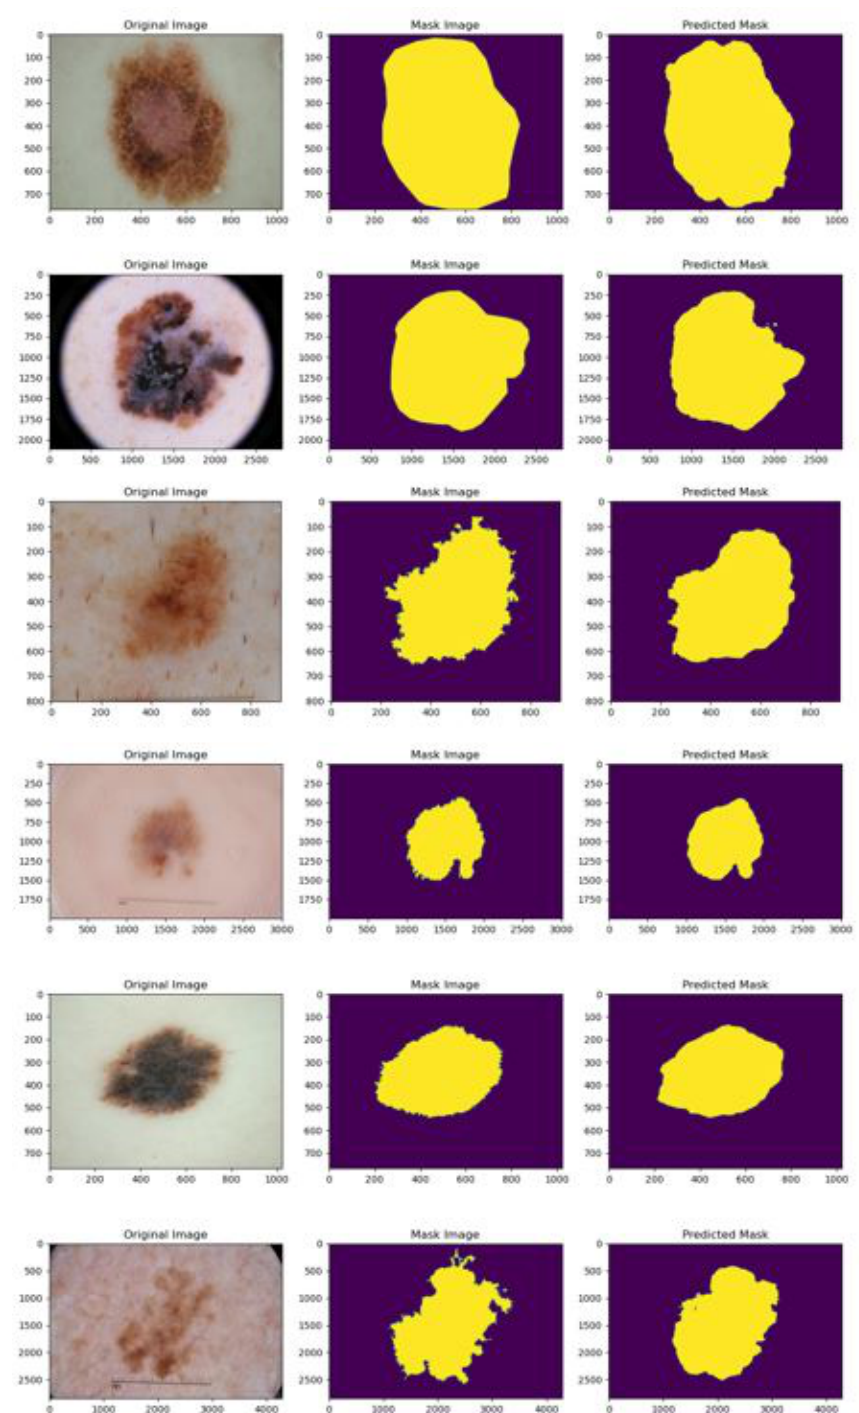
Figure 9. Qualitative results of MAAU on the ISIC 2018